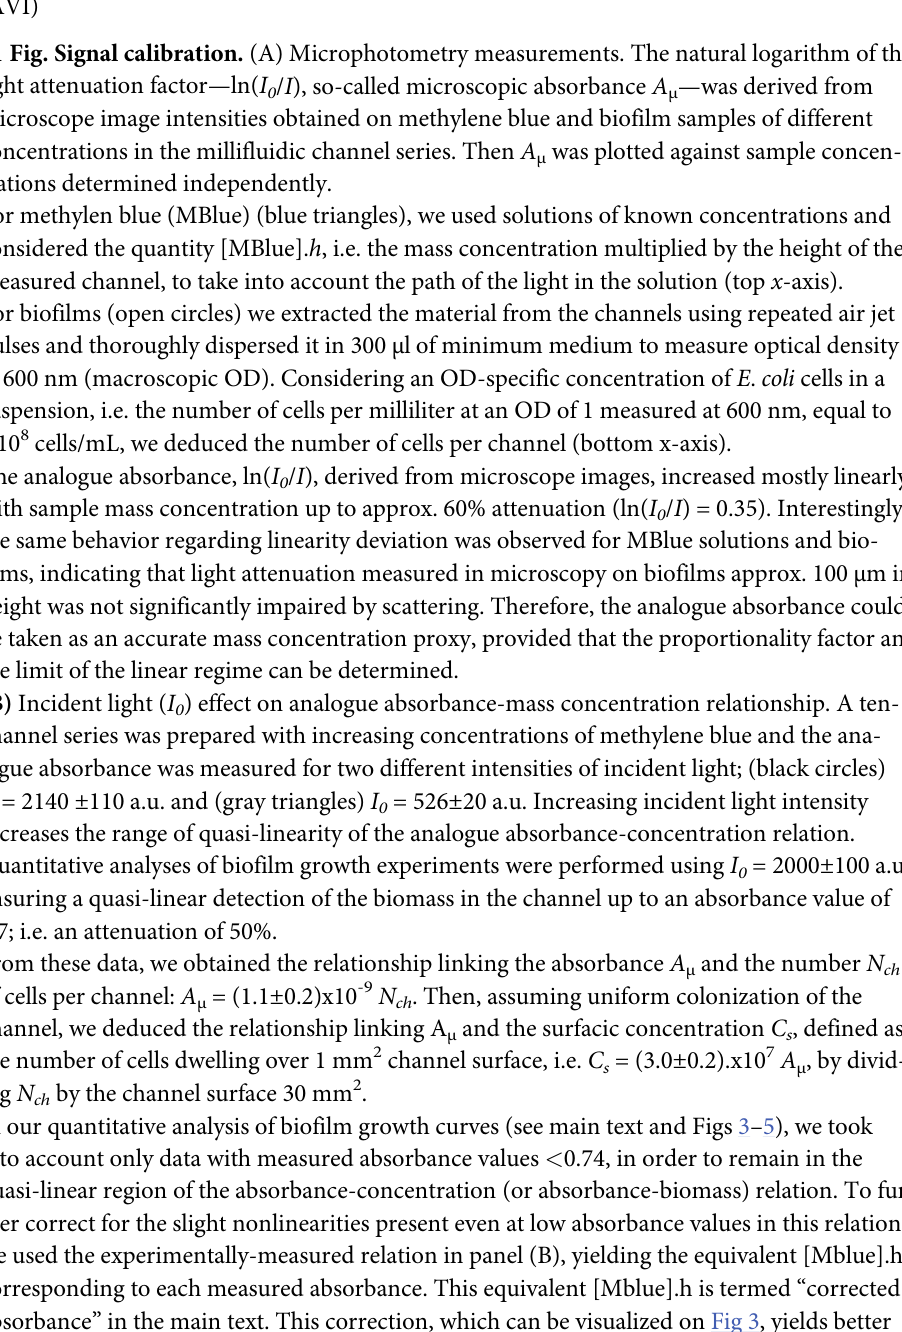
S2 Fig. Velocity field in channels without biofilm. A : Velocity field in a channel of height h = 1 mm without biofilm. Dots: experimentally-measured velocities v at various positions (y , z) across the channel. Surface: adjustment to the theoretical expression of the velocity field of a viscous fluid in a rectangular channel (Eq 2). The color scale denotes velocities (see v